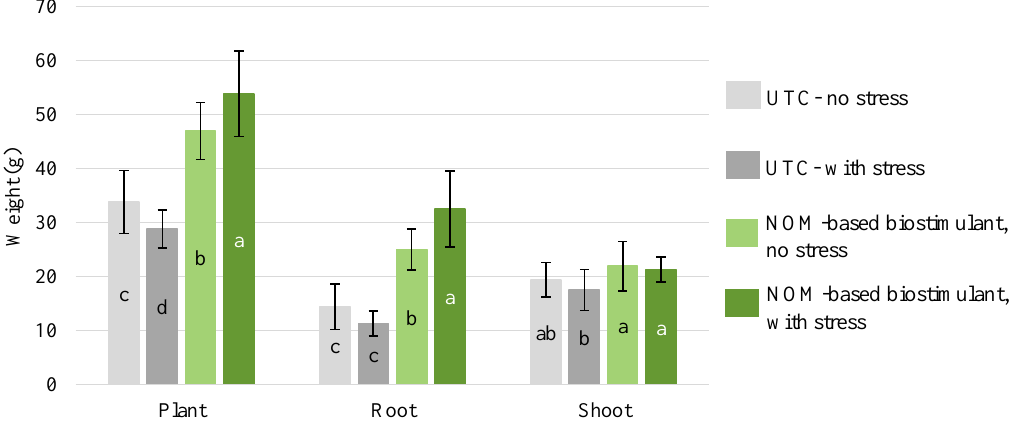
Figure 2. Average plant, root, and shoot weights 11 days after the induced salt stress during the tomato nursery trial using soil applications for the UTC non-stressed plants, UTC stressed plants, NOM-based biostimulant treated non-stressed plants, and NOM-based biostimulant treated stressed plants. Means with the same letter designation centered on each bar do not differ significantly ( p = 0.10, least significant difference), and error bars represent one standard deviation. See also Supplementary Table S2, where ANOVA p values are reported.